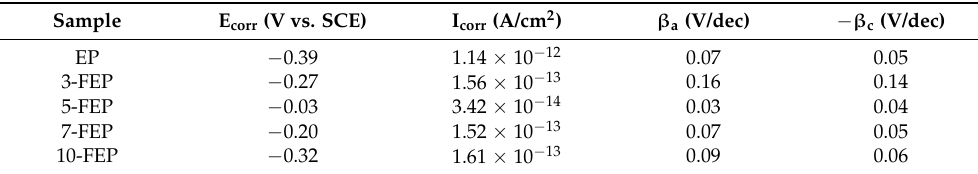
Figure 12. Polarization curve of composite coating. Table 1. Electrochemical polarization corrosion parameters. Table 1. Electrochemical polarization corrosion